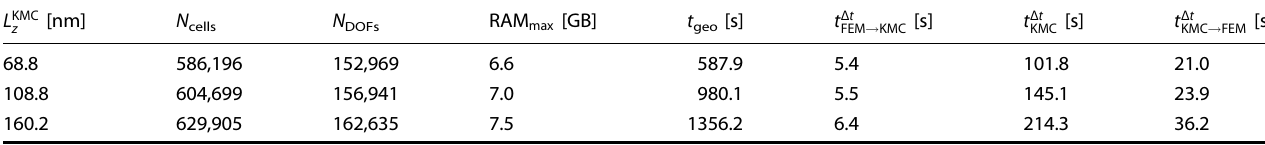
L KMC z is the KMC box size along z ; N cells and N DOFs the number of cells and degrees of freedom (DOFs) in the input FEM mesh, respectively; RAM max the maximum RAM per core needed for a simulation; t geo the time spent to convert the mesh into a KMC box; t Δ t FEM ! KMC the time spent to map the thermal fi eld from FEM to KMC at each FEM-KMC cycle time interval Δ t , averaged over all simulations using the same KMC box; t Δ t KMC the average KMC runtime every Δ t ; t Δ t KMC ! FEM the average time to map the KMC atomic-scale phases back to the FEM every Δ t . The total runtime for the FEM-KMC simulation is approximately (cid:6) (cid:7) = Δ t þ t (cid:2) t given by: Δ t TOT (cid:4) t geo þ t Δ t FEM ! KMC þ t Δ t KMC þ t Δ t KMC ! FEM M FEM , with t M being the time elapsed while melting ( T > T M ) and t FEM the sum of heating and cooling times, elapsed while T < T M . All memory and time information are reported per CPU core. Simulations were run on an AMD EPYC 7742 64-Core processor.